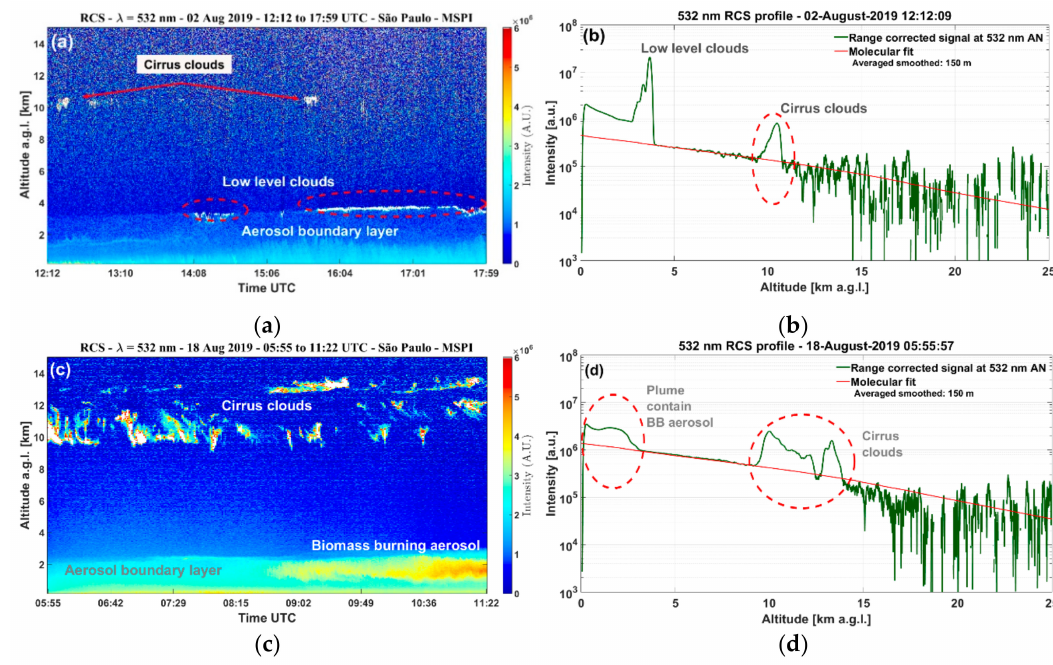
Figure 6. LiDAR corrected signal time-height cross-sections ( a , c ), and the associated averaged Range Corrected signal profiles ( b , d ) at 532 nm as recorded at S ã o Paulo (Brazil) on 2nd and 18th August 2019, respectively. The red lines indicate the molecular contribution to the total backscattered